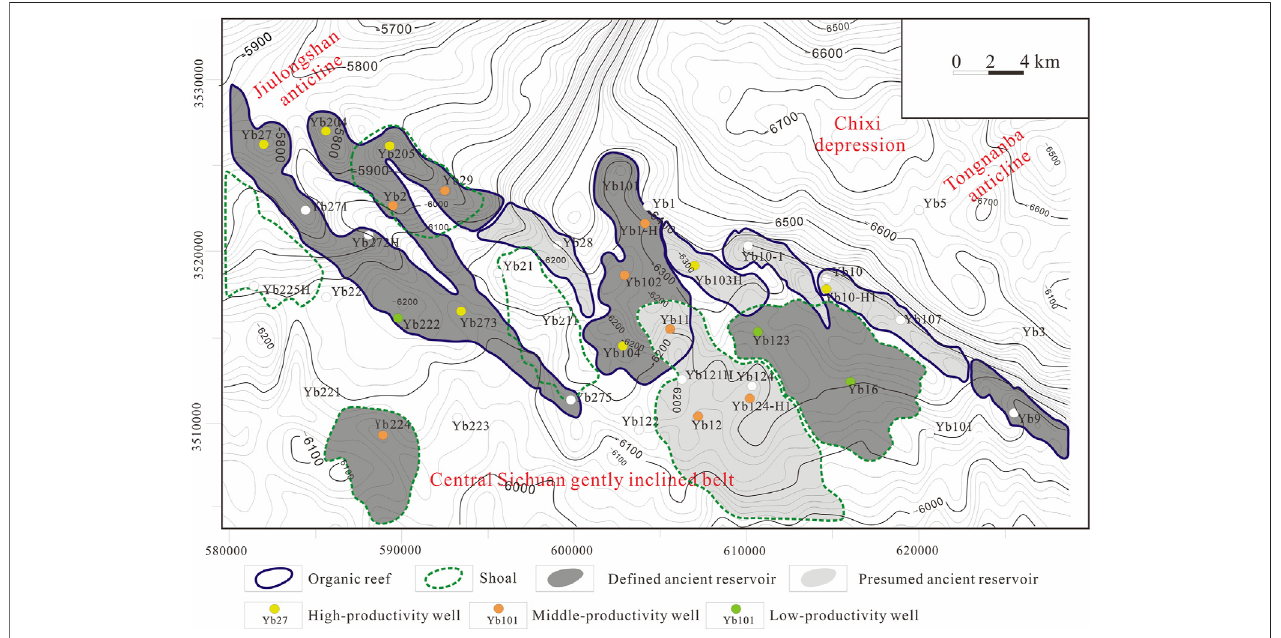
FIGURE 3 | Distribution diagram of reservoirs in the Changxing Formation in the Yuanba Gas Field (modi fi ed after Guo, 2019).